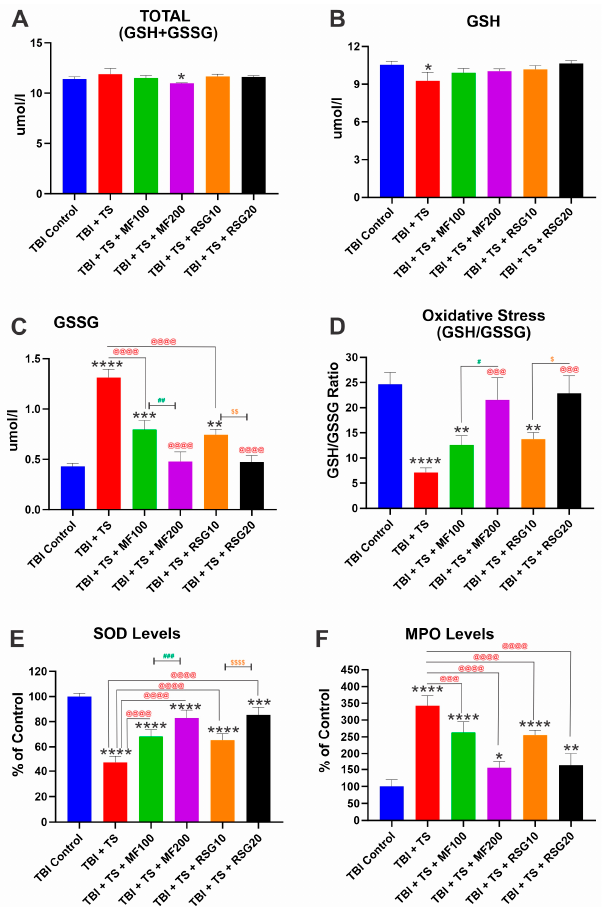
Figure 4. MF and RSG affect OS generated after premorbid TS exposure and TBI induction of mice. ( A ) total glutathione (GSH+ GSSG), ( B ) reduced glutathione (GSH), ( C ) oxidized glutathione (GSSG), ( D ) GSH/GSSG, ( E ) SOD levels, and ( F ) MPO levels. n = 6 biological replicates, * p < 0.05, ** p < 0.01, *** p < 0.001, **** p < 0.0001 versus control. @@@ p < 0.001, @@@@ p < 0.0001 non-treated versus MF/RSG-treated group. # p < 0.05, ## p < 0.01, ### p < 0.001 MF100 versus MF200. $ p < 0.05, $$ p < 0.01, $$$$ p < 0.0001 RSG10 versus RSG20.